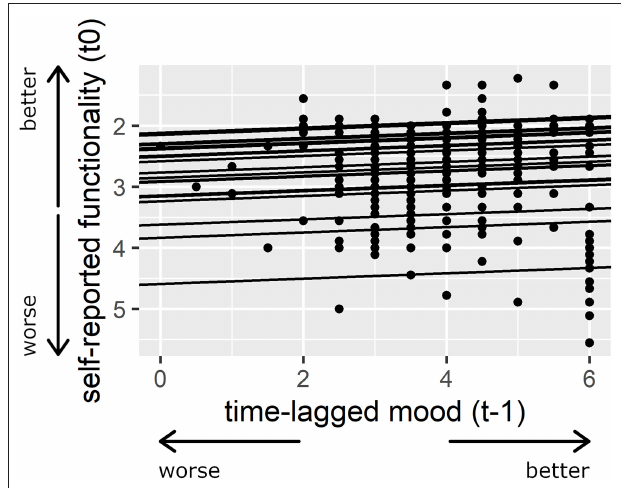
FIGURE 2 | Association between patients’ time-lagged mood (t-1) and their self-reported functionality. Larger numbers indicate a better mood and smaller numbers indicate a more positive self-assessment. The regression lines illustrate the random intercepts and slopes model for patients’ time-lagged mood (t-1) as the predictor variable and patients’ self-reported functionality as the dependent variable. For presentation purposes, a model is presented here in which mood was not person-mean